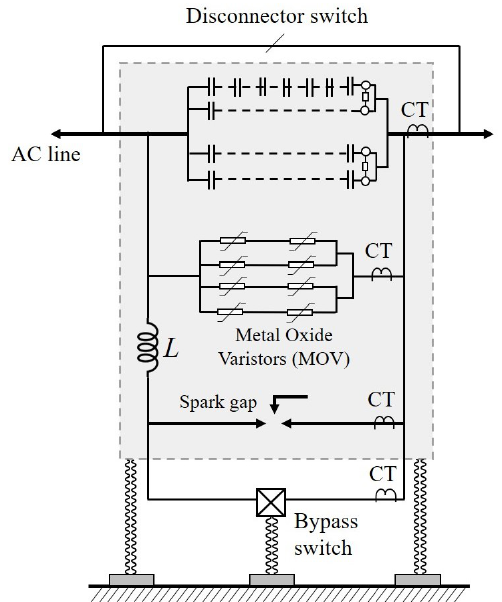
Figure 5. Components of the Fixed Series Capacitor (FSC). From Reference [4], based on Reference